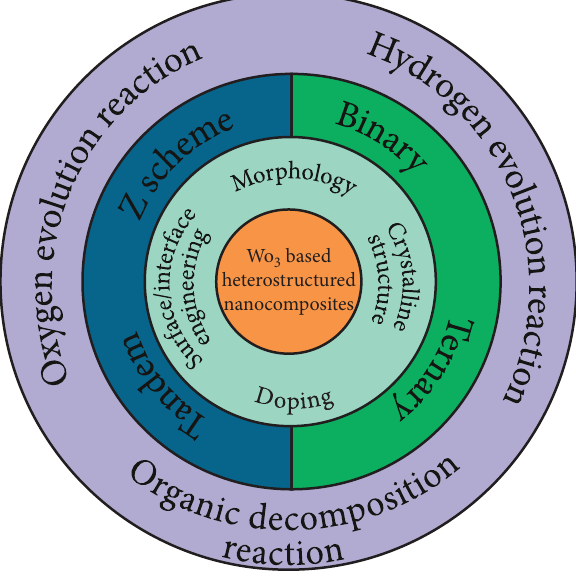
Figure 1: Tungsten